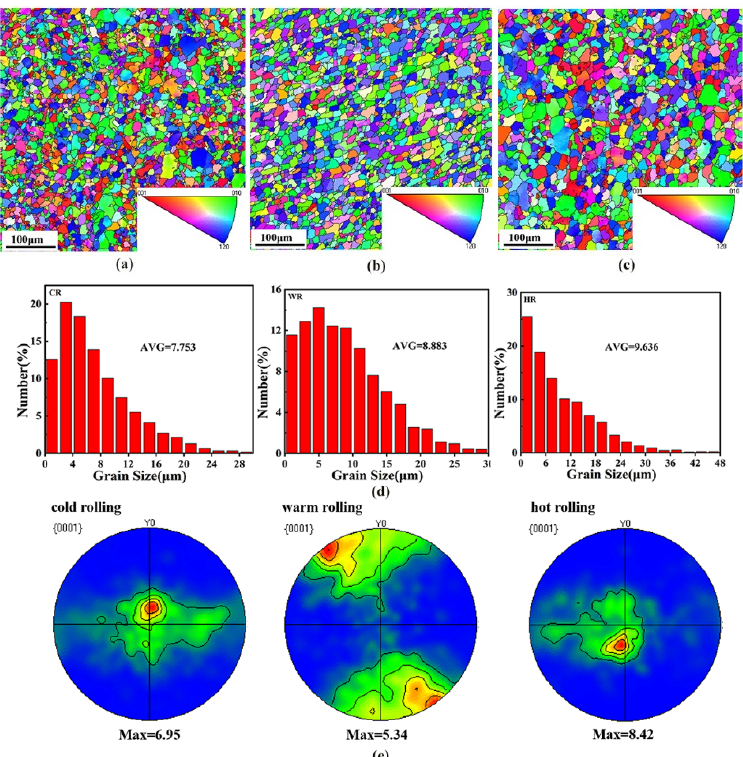
Figure 4. The IPF maps in the RD-SD plane (distribution of crystallographic direction parallel to CD) showing the microstructures of the WE43 alloy after rolling. ( a ) Cold-rolled, ( b ) warm-rolled, and ( c ) hot-rolled, and ( d ) distribution map of different rolled grain sizes. ( e ) Basal (0001) recalculated pole figures of the WE43 alloy.